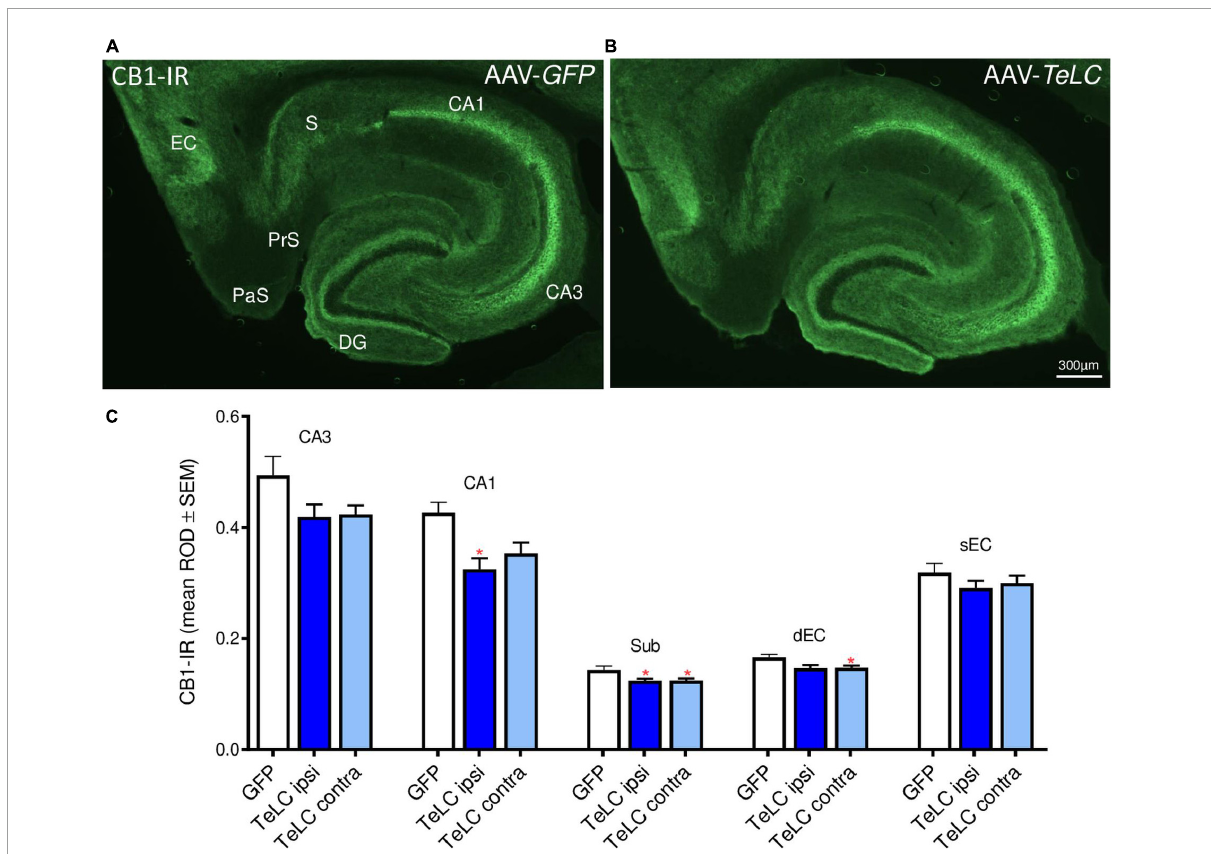
FIGURE9 CB1-IR after AAV- TeLC injection. Immunofluorescence of horizontal sections on the level of the ventral hippocampus of mice injected into the subiculum with (A) AAV- GFP or (B) AAV- TeLC . CB1-IR is highly expressed in pyramidal layers of CA3, CA1, the subiculum and in the inner molecular layer of the dentate gyrus, layers that are innervated by basket cells. CB1-IR is presumably located presynaptically on these GABA-ergic terminals mediating inhibition of GABA release. (C) Optic density of CB1-IR is modestly reduced in sectors CA3 (statistically not significant) and CA1 ( p < 0.05, ipsilateral side), in the subiculum ( p < 0.05, *) and in the deep layers of the entorhinal cortex ( p < 0.05, contralateral side). Note that the ROD values were not significantly different in the AAV- TeLC -injected side versus the not-injected contralateral area. Abbreviations in panels (A,C) : DG, dentate gyrus; EC, entorhinal cortex; dEC, deep entorhinal cortex; sEC, superficial entorhinal cortex; S, Sub, subiculum; PaS, parasubiculum; PrS,